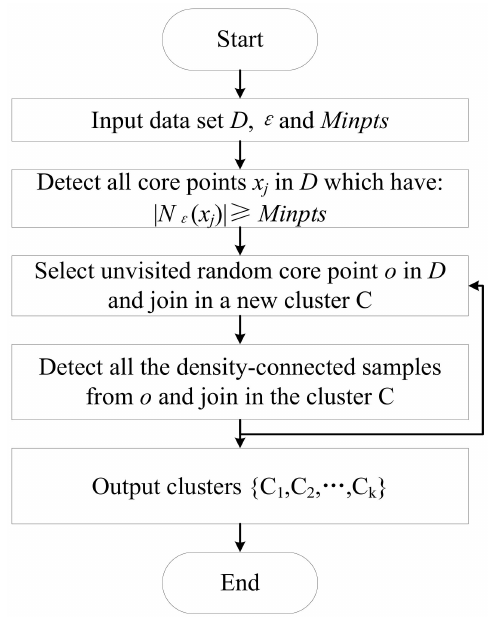
Figure A3. Framework of DBSCAN